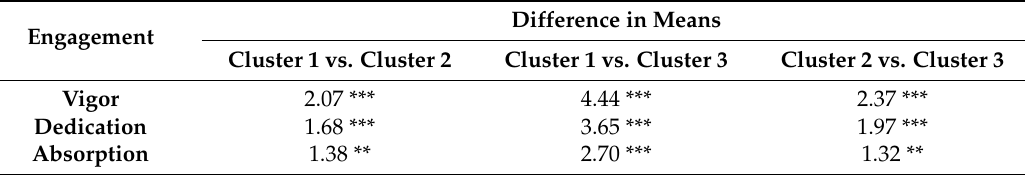
Table 5. Post hoc tests by cluster for engagement